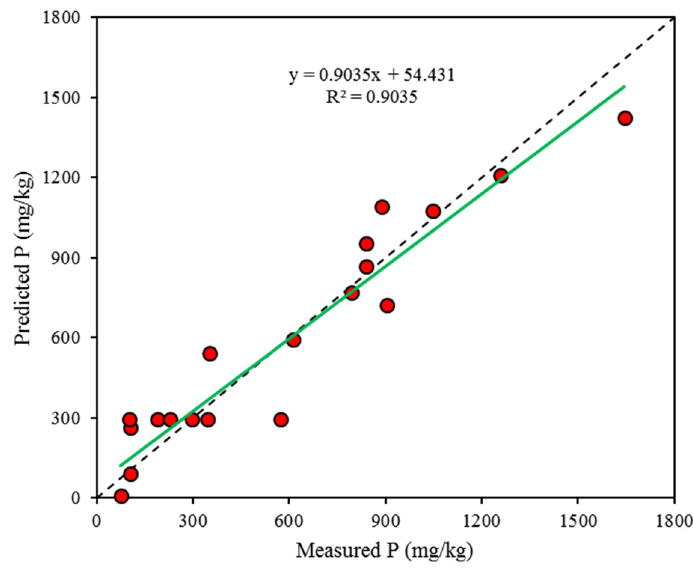
Figure 1. The comparison of the observed dissolved phosphate concentrations and the concentrations predicted by the central composite design model.